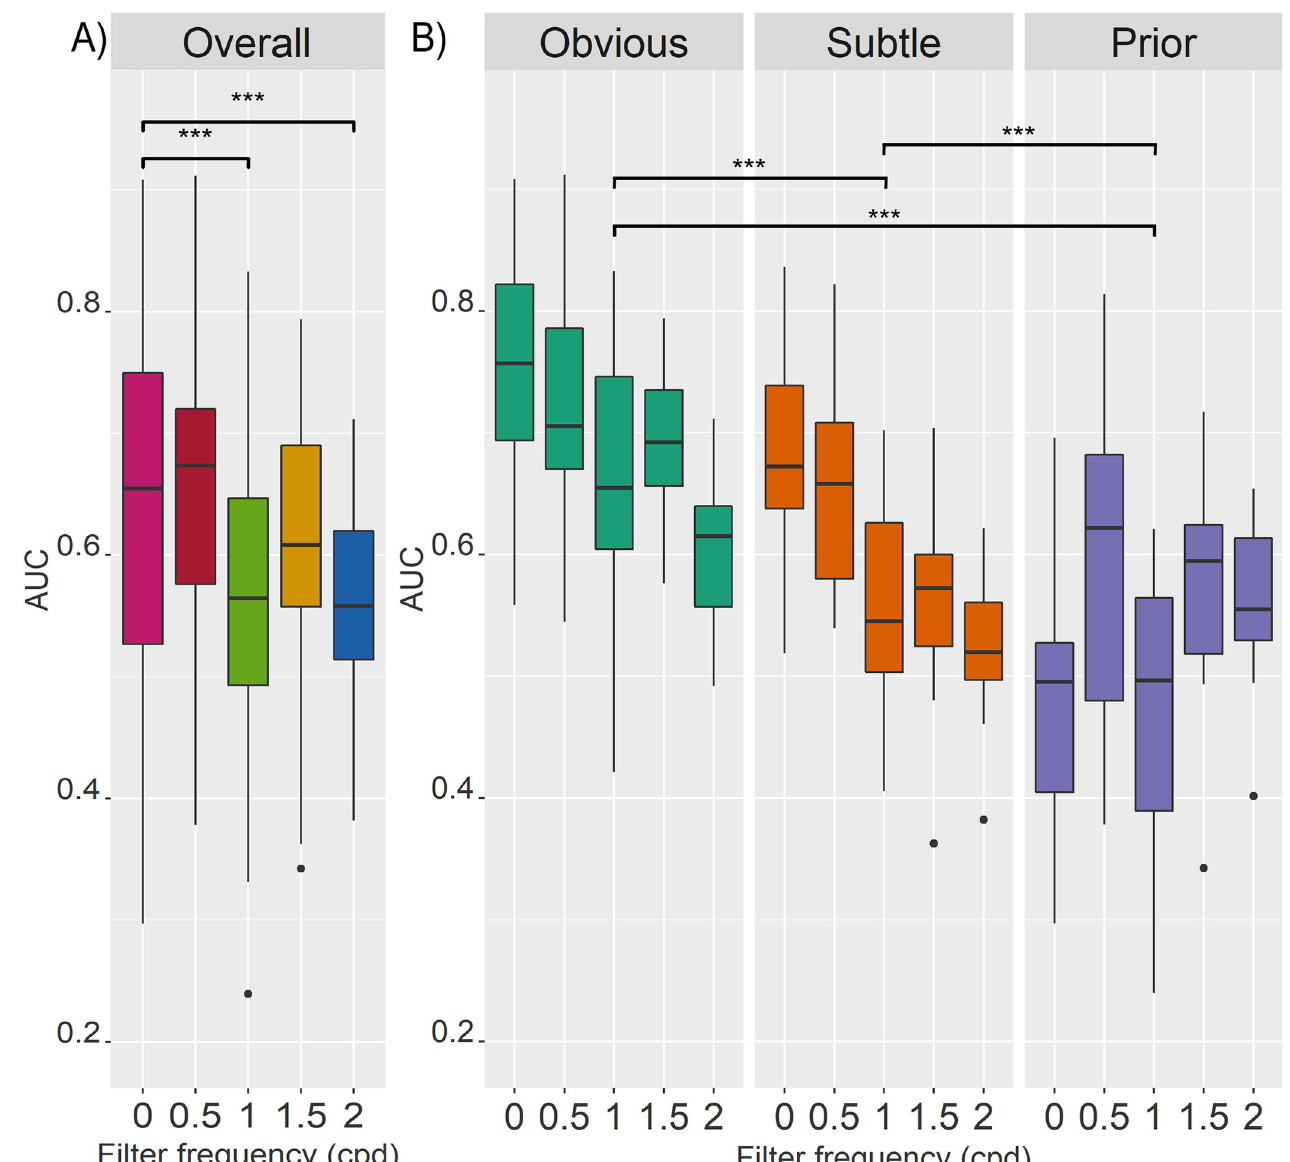
Fig 4. Boxplots of AUC across conditions. Each boxplot shows the median as the line within the coloured box containing the 25 th and 75 th percentiles, with extending whiskers containing the 95% CI, with any outliers plotted as dots. Significance of pairwise comparisons is indicated in the figure with � = p < .05, �� = p < .01, ��� = p < .001. (A) Boxplots showing AUC across frequency conditions (0, 0.5, 1, 1.5, and 2 cpd). Pairwise comparisons of frequency showed that AUC was significantly higher for F0 than F1 (estimated difference = 0.089, t(273) = 6.533, p = < .0001) and F2 (estimated difference = 0.098, t(284) = 5.647, p = < .0001), but did not differ significantly from F0.5 (estimated difference = -0.025, t(273) = -1.827, p = .360) and F1.5 (estimated difference = 0.023, t(284) = 1.306, p = .688). (B) Boxplots showing AUC for each mammogram category (obvious, subtle, and prior) and frequency, to illustrate mammogram category and interaction effects. Pairwise comparisons of mammogram category showed that D’ was significantly higher obvious than subtle (estimated difference = 0.089, t (258) = 7.058, p = < .0001) and prior mammograms (estimated difference = 0.156, t(258) = 12.368, p = < .0001), and higher for subtle than prior mammograms (estimated difference = 0.068, t(258) = 5.310, p = <